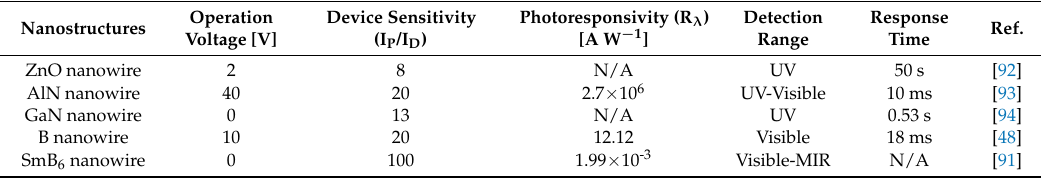
Table 4. The comparable table of the working performances of various nanodevices. UV: ultraviolet, MIR: middle infrared.